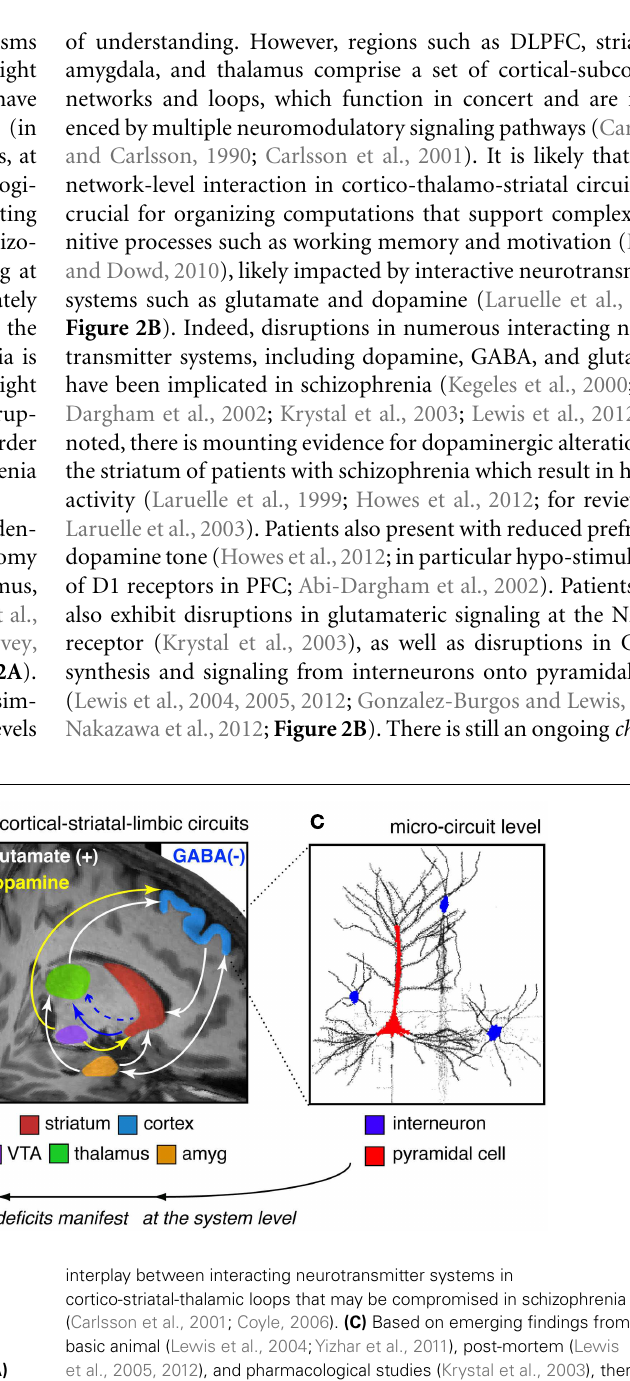
FIGURE 2 | Conceptual illustration of neural circuitry across levels of computation that may be involved in affective and cognitive disturbances in schizophrenia. The figure highlights how, in order to explain deficits at the phenomenological/behavioral level, we need to bridge observations across multiple levels of analysis in schizophrenia. (A) At the regional level there is clear evidence for both structural and functional abnormalities in cortical (Csernansky et al., 1998, 2004, 2008; Harms et al., 2010, 2012) and striatal/thalamic circuits in schizophrenia (Csernansky et al., 1998, 2004, 2008; Laruelle et al., 1999; Harms et al., 2007; Reichenberg and Harvey, 2007; Dowd and Barch, 2010; Mamah et al., 2010). (B) However, less is known about how some of these regional deficits manifest in possible system-level disruptions in functional loops between prefrontal, striatal, limbic, and thalamic nodes in schizophrenia (Lisman, 2012). Deficits in these interacting functional systems need to be considered when interpreting abnormalities between affective/hot and cognitive/cold operations in schizophrenia. Furthermore, there is known